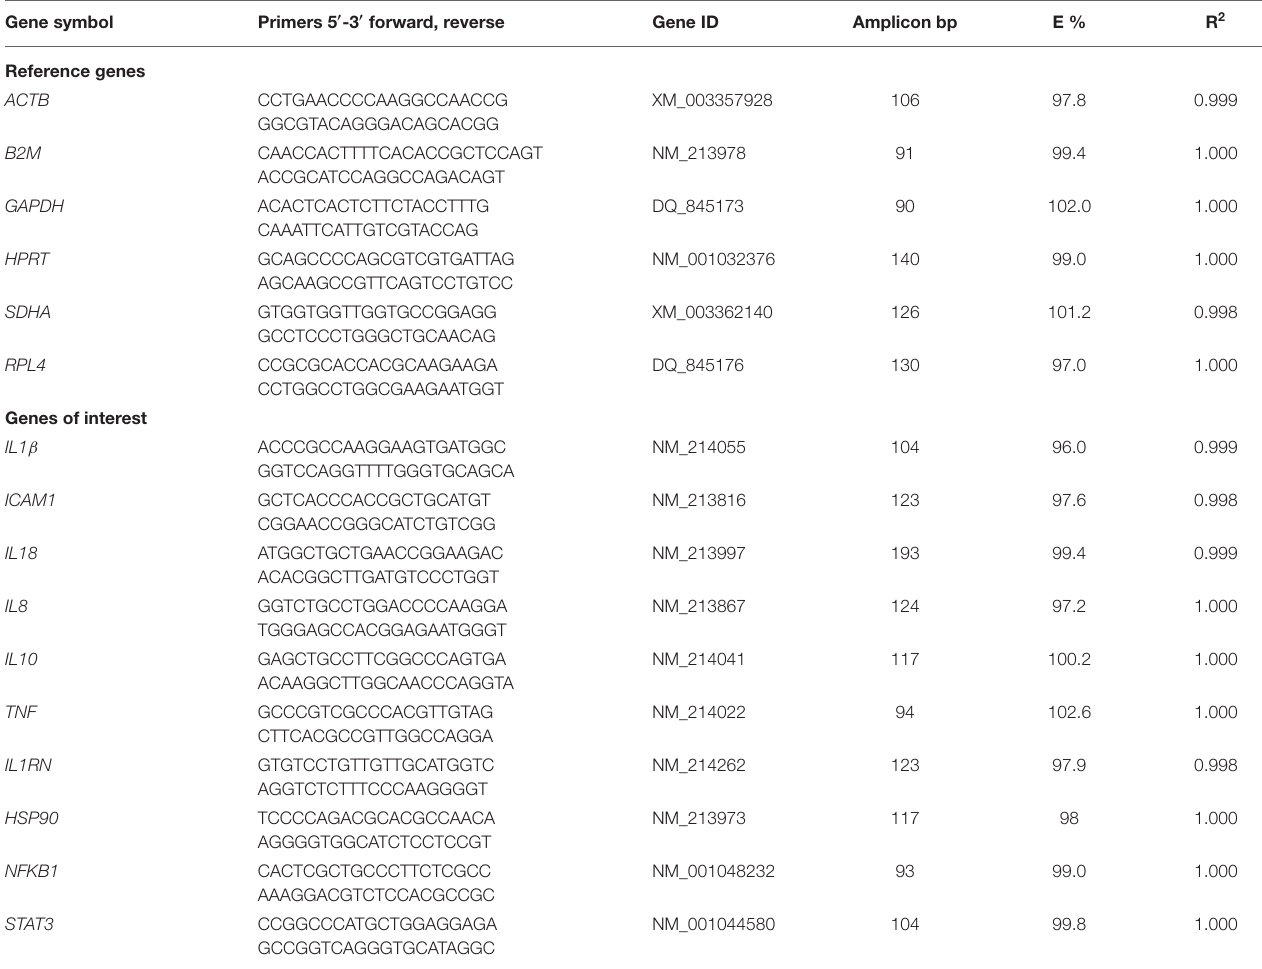
TABLE 2 | Primer sequence for reference genes and genes of interest and qPCR efficiency. Gene